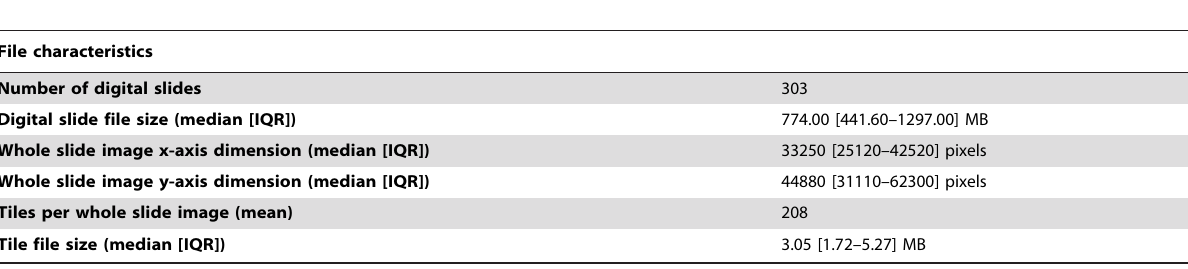
Table 4. Digital slide file characteristics from Run